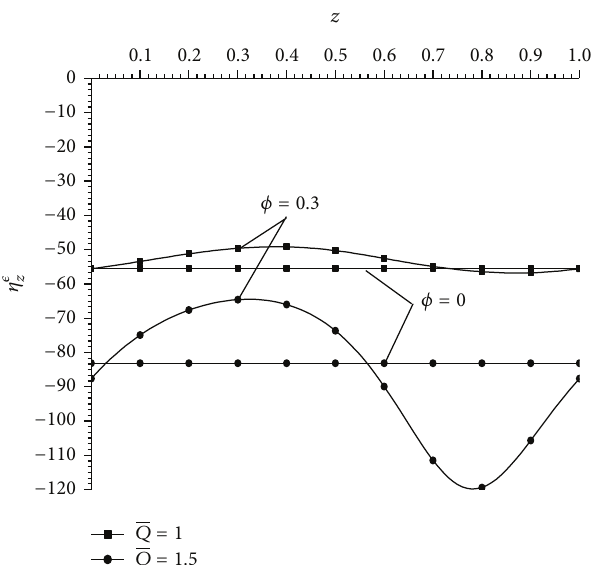
Figure 9: Variation of wall vorticity 𝜂 𝜖 𝑧 versus 𝑧 with different values of 𝑄 and 𝜙 at Wi = 0.02 , 𝛿 = 0.1 , 𝜖 = 0.01 , and Re = 1 .